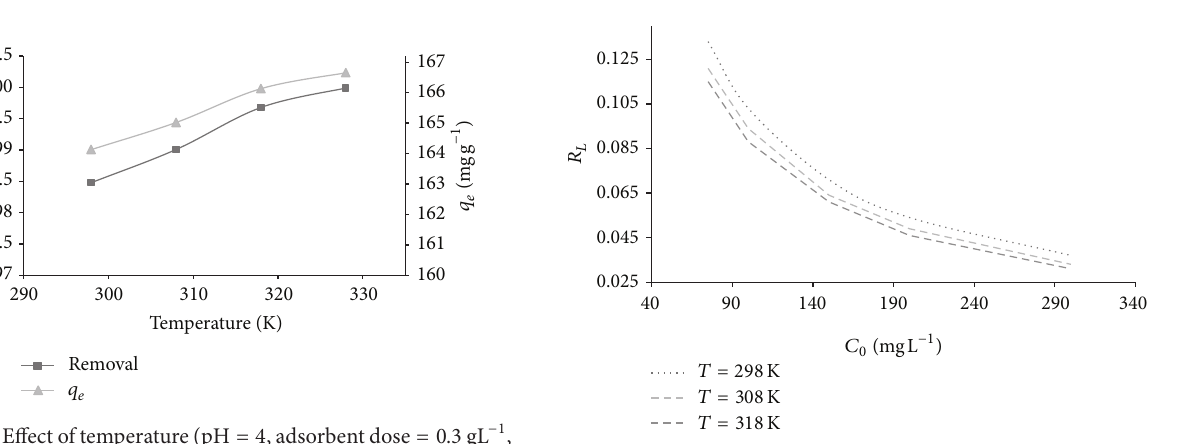
Figure 7: Effect of temperature (pH = 4 , adsorbent dose = 0.3 gL −1 , = 50 mgL −1 , 𝑡 = 80 min, A . S . = 170 rpm). 𝐶 𝑜